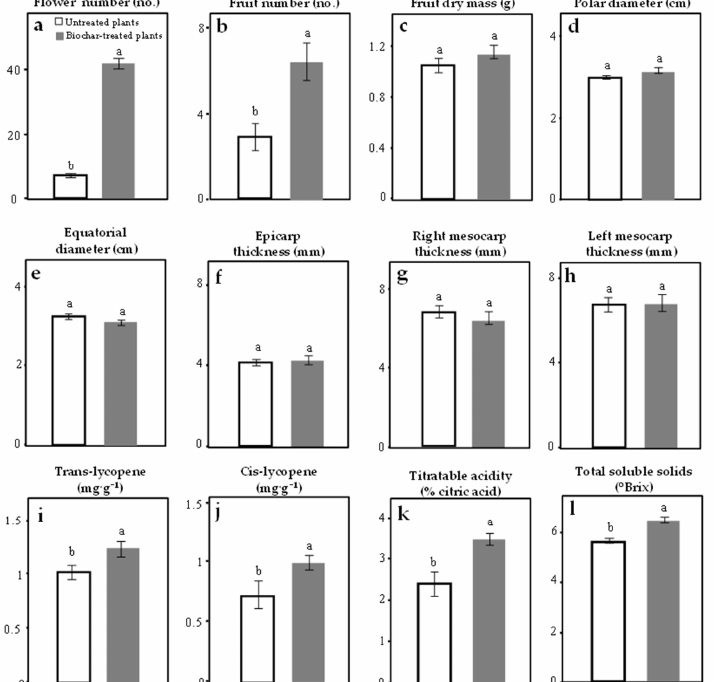
Figure 3. Flower number ( a ), fruit number ( b ), dry mass ( c ), polar ( d ) and equatorial diameter ( e ), epicarp thickness ( f ), right mesocarp ( g ) and left mesocarp thickness ( h ), trans-lycopene ( i ), cis- lycopene ( j ), titratable acidity ( k ), and total soluble solid content ( l ) measured for Solanum lycopersicum var. cerasiforme plants grown on the two different substrates (white box, plants in the untreated substrate; gray box, plants in the biochar-treated substrate). Letters indicate statistically significant differences ( p < 0.05) ( n = 10 ±